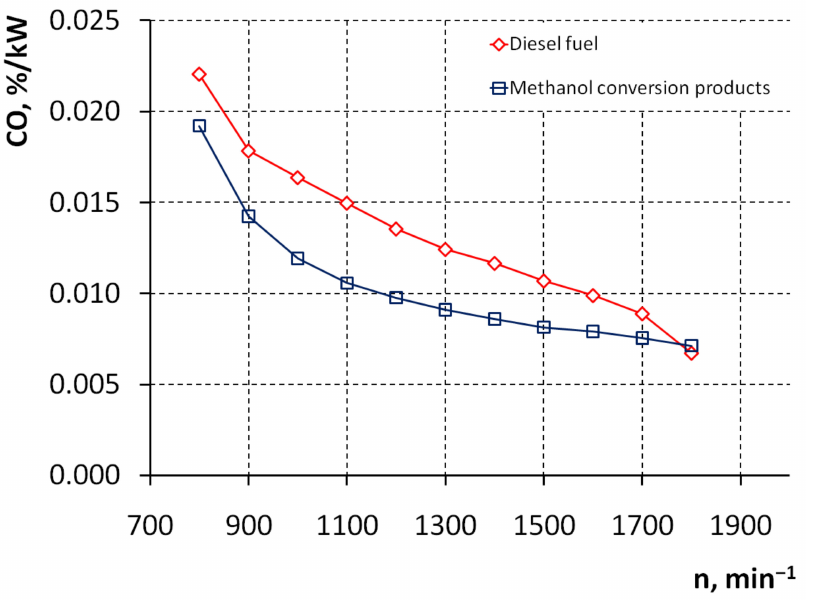
Figure 12. Experimental dependences of the content of carbon monoxide in the exhaust gases on the crankshaft speed of the engine n for different motor fuels.